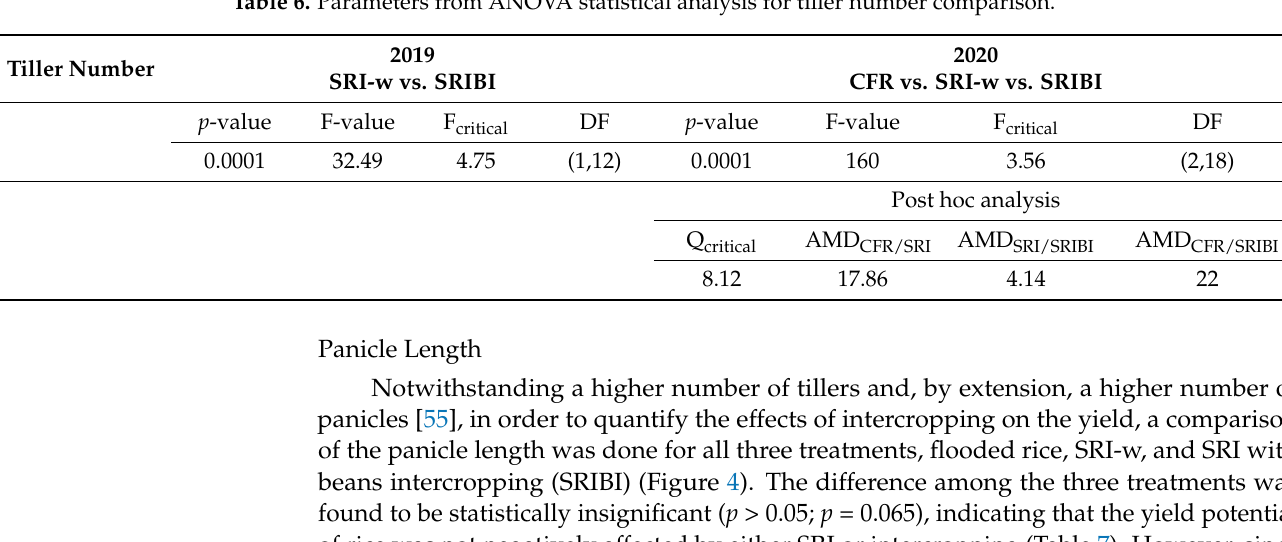
Figure 3. Mean number of tillers in the intercropping treatment and the conventional rice treatment ( Left : 2019; Right : 2020). Table 6. Parameters from ANOVA statistical analysis for tiller number